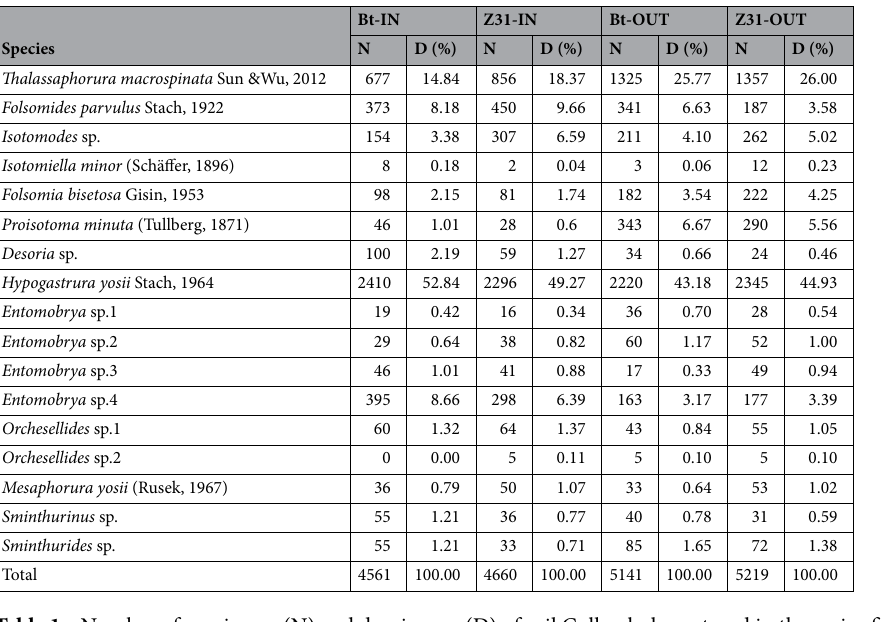
Table 1. Number of specimens (N) and dominance (D) of soil Collembola captured in the maize fields that received different experimental treatments. For treatments see the “Methods” section.